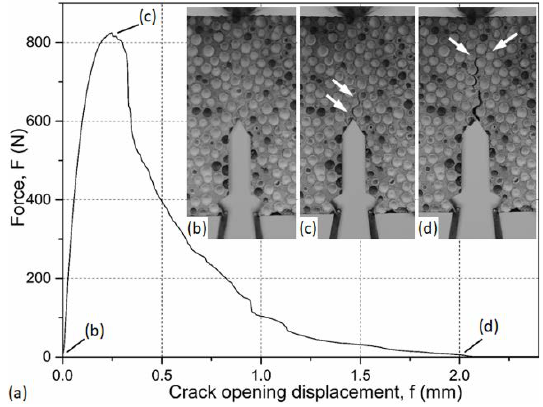
Figure 7. Fracture process of notched MMSFs ( a ) the force–crack opening displacement curve and the fracture surface of the AlSi12-V-1 sample; ( b – d ) crack propagation in the sample.